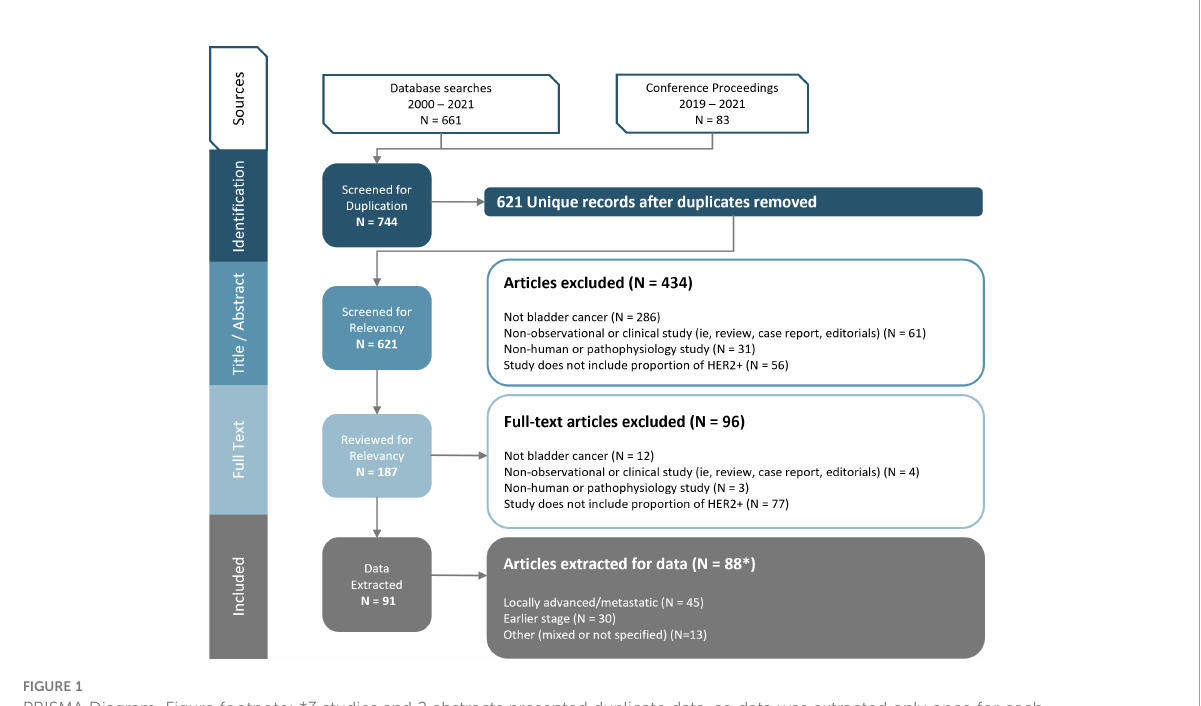
FIGURE 1 PRISMA Diagram. Figure footnote: *3 studies and 2 abstracts presented duplicate data, so data was extracted only once for each respective